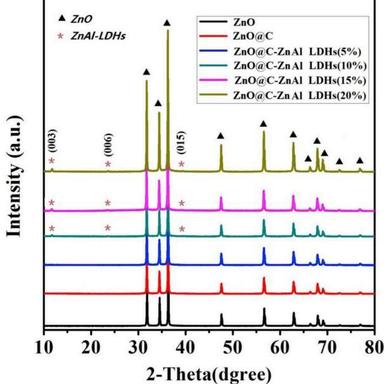
XRD patterns of the as-prepared ZnO, ZnO@C, ZnO@C-ZnAl LDHs composites.